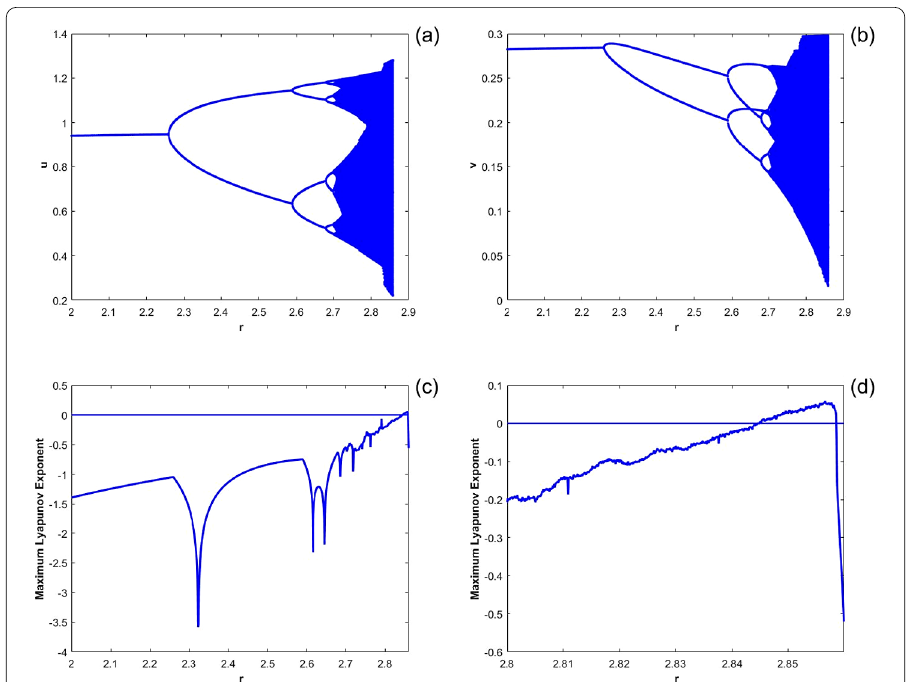
Figure 5 ( a ) Bifurcation diagram of map (3) in the ( r , u ) plane with initial value (0.6,0.3). ( b ) Bifurcation diagram of map (3) in the ( r , v ) plane. ( c ) Maximum Lyapunov exponents corresponding to Figs. 3(a), (b). ( d ) Local amplification diagram of ( a ) for δ ∈